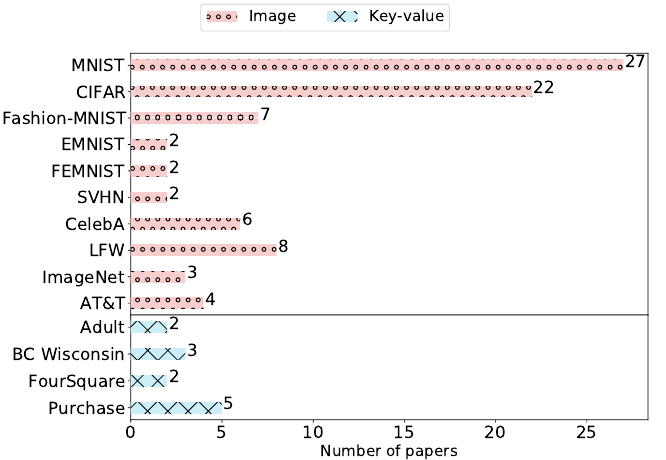
Figure 7. Target model types used to evaluate the attacks. Most of the papers evaluated their models against more than one other model.